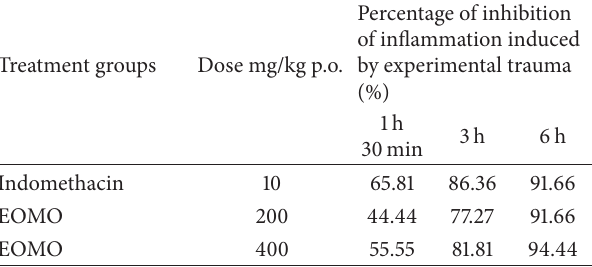
Table 4: Percentage of inhibition of inflammation of essential oil of Melissa officinalis L . using experimental trauma-induced rat paw edema. Treatment groups Dose mg/kg p.o.